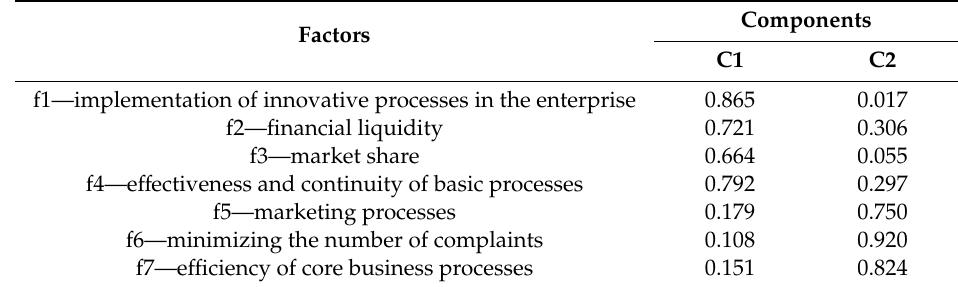
Table 19. Matrix of rotated components for factors of the importance of relationships with Customers 4.0 for the development of innovative enterprises.